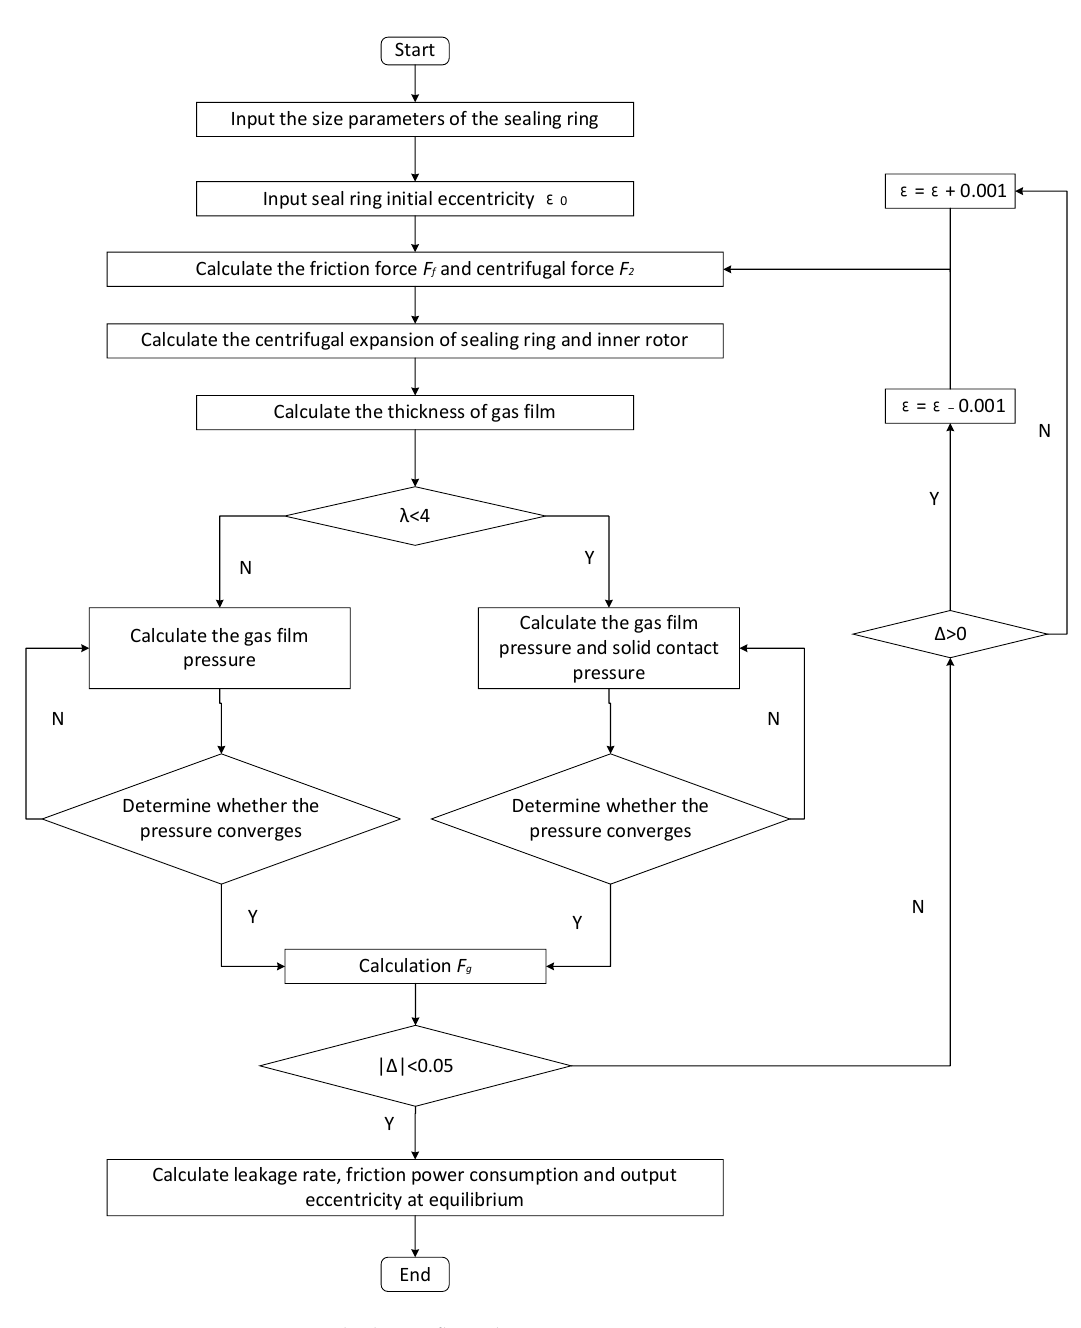
Figure 3. Calculation flow chart.